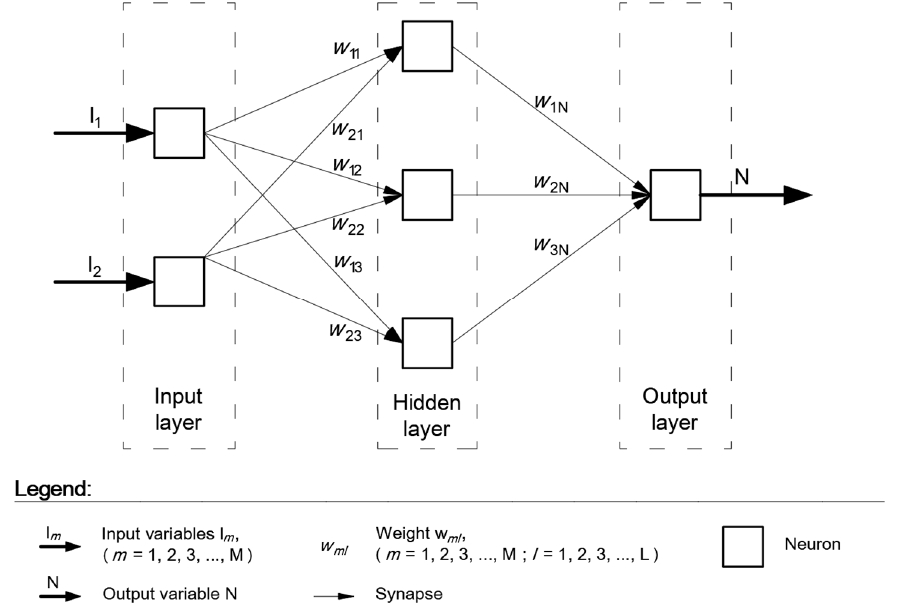
Figure 1. Exemplary structure of a two-layer neural network.